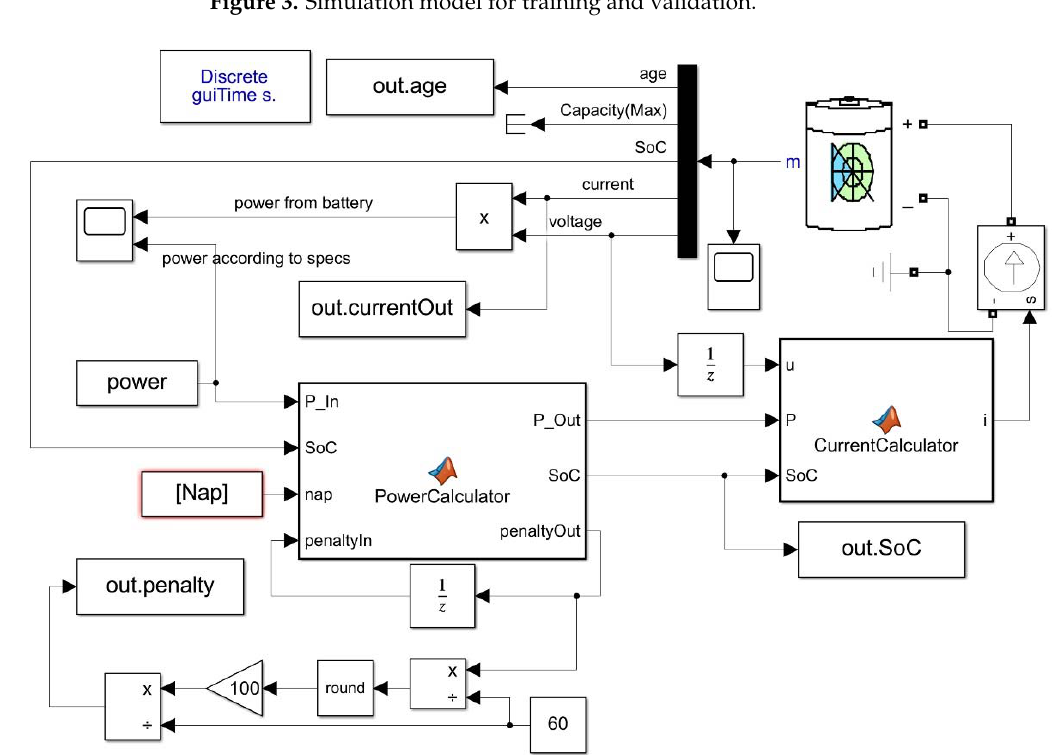
Figure 4. Simulation model for performance estimation.